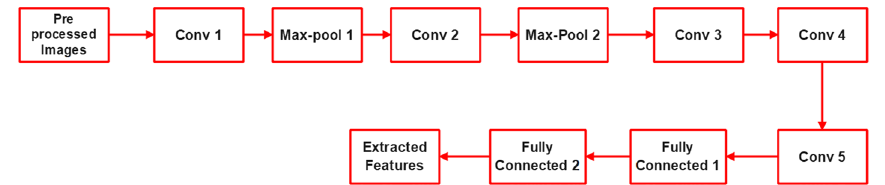
Fig. 3 AlexNet architecture in feature